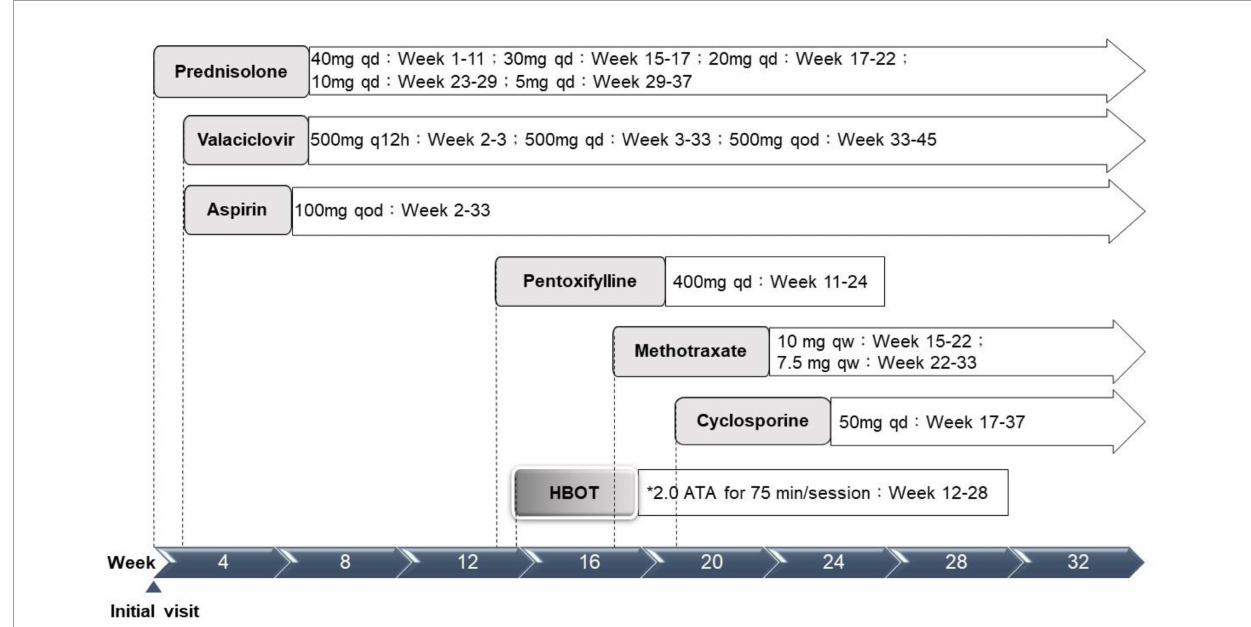
FIGURE3 Treatment timeline. ATA, atmosphere absolute; HBOT, hyperbaric oxygen therapy; qd, every day; q12h, every 12 hours; qod, every other day; qw, every week. *Treatment protocol: 2.0 ATA for 75 min per session, 1 session per day, 5 days per week.